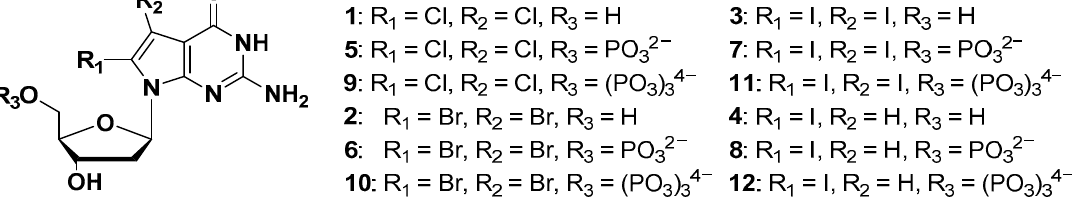
Figure 1. Structures of 8-substituted 7-deaza-dG derivatives and 7,8-disubstituted 7-deaza-dG derivatives.